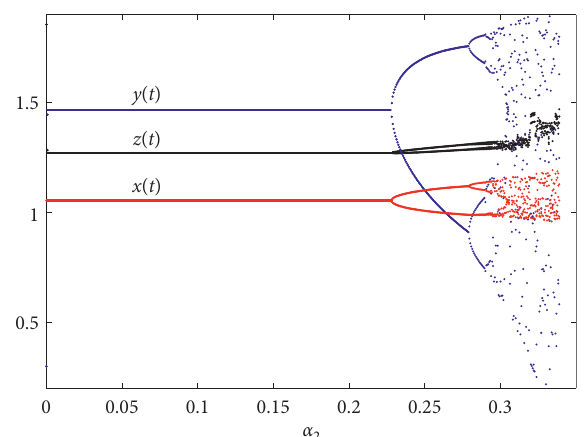
Figure 3: Bifurcation diagram for α